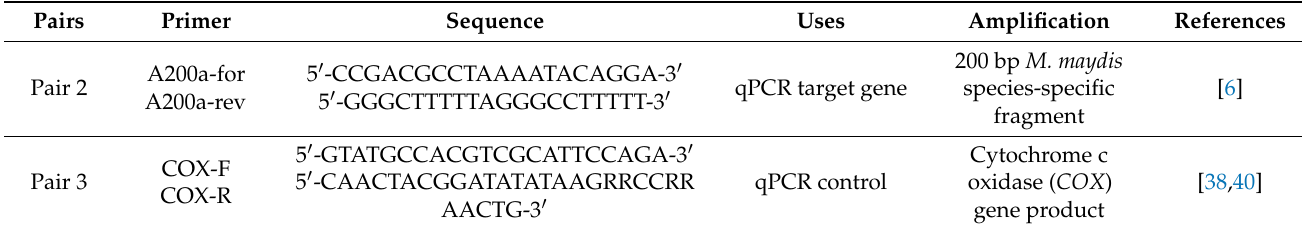
Table 3. Primers used in this